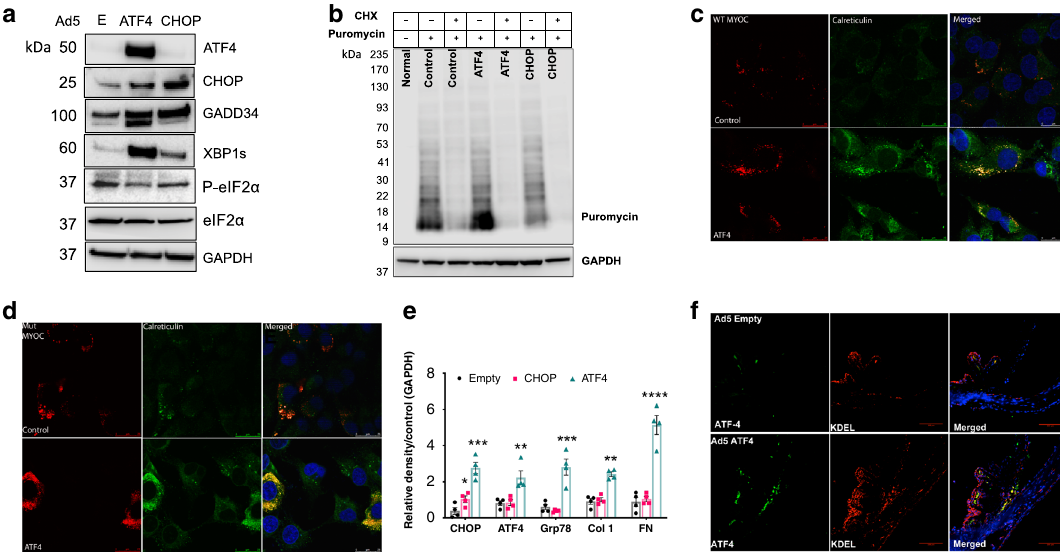
Fig. 5 ATF4 increases protein synthesis and ER client protein load in TM cells and tissues. a GTM3 cells were transduced with Ad5.Empty, ATF4, and CHOP for 36 h. and cellular lysates were examined for markers of chronic ER stress by Western blot analysis. Expression of ATF4 increased XBP-1 (s) and GADD34 while ATF4 reduced p-eIF2 α ( n = 3 replicates). b GTM3 cells transfected with ATF4 or CHOP were incubated with cycloheximide (CHX) (10 μ g/ ml) for 16 h. Puromycin (10 µ g/ml) was added to cells for 30 min before harvesting cell lysates. Total cellular lysates were subjected to Western blot analysis using anti-puromycin and GAPDH antibodies. Increased puromycin incorporation observed in the total ER fractions of ATF4 transfected cells ( n = 3 replicates), which was blocked by CHX signifying a higher rate of de novo protein synthesis. c and d GTM3 cells stably expressing DsRed-tagged WT c or mutant d MYOC were transfected with plasmids expressing Empty and ATF4 for 48 h. Cells were fi xed and stained with calreticulin (ER marker). ATF4 increased intracellular WT and mutant myocilin accumulation in the ER as evident from a strong colocalization of myocilin with calreticulin in ATF4- transfected cells ( n = 3 replicates). Scale bar is 25 µ m. e 3-month-old C57BL/6J mice were intravitreally injected with Ad5.Empty, Ad5.ATF4, and Ad5. CHOP (2 × 10 7 pfu/eye). After 3 weeks of injections, anterior segment lysates were subjected to Western blot (Supplementary Fig. 15) and densitometric analyses e of ECM ( fi bronectin, collagen-1) and ER stress (Grp78, ATF4, and CHOP) markers ( n = 4 mice; data are presented as mean ± SEM, one-way ANOVA, * P < 0.05, ** P < 0.01, *** P < 0.001, **** P < 0.0001). f Increased ATF4 and KDEL staining in TM of Ad5.ATF4-injected mice compared to Ad5. Empty-injected mice ( n = 3 mice). Scale bar is 100 µ